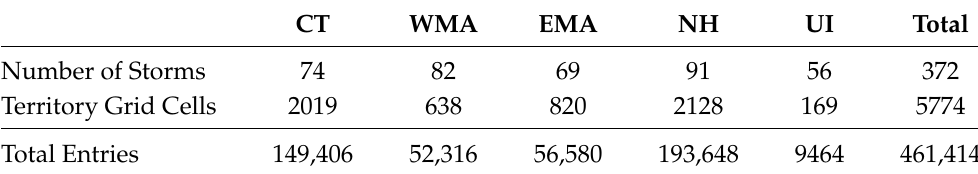
Table 1. The amount of data available for training the thunderstorm-related outage